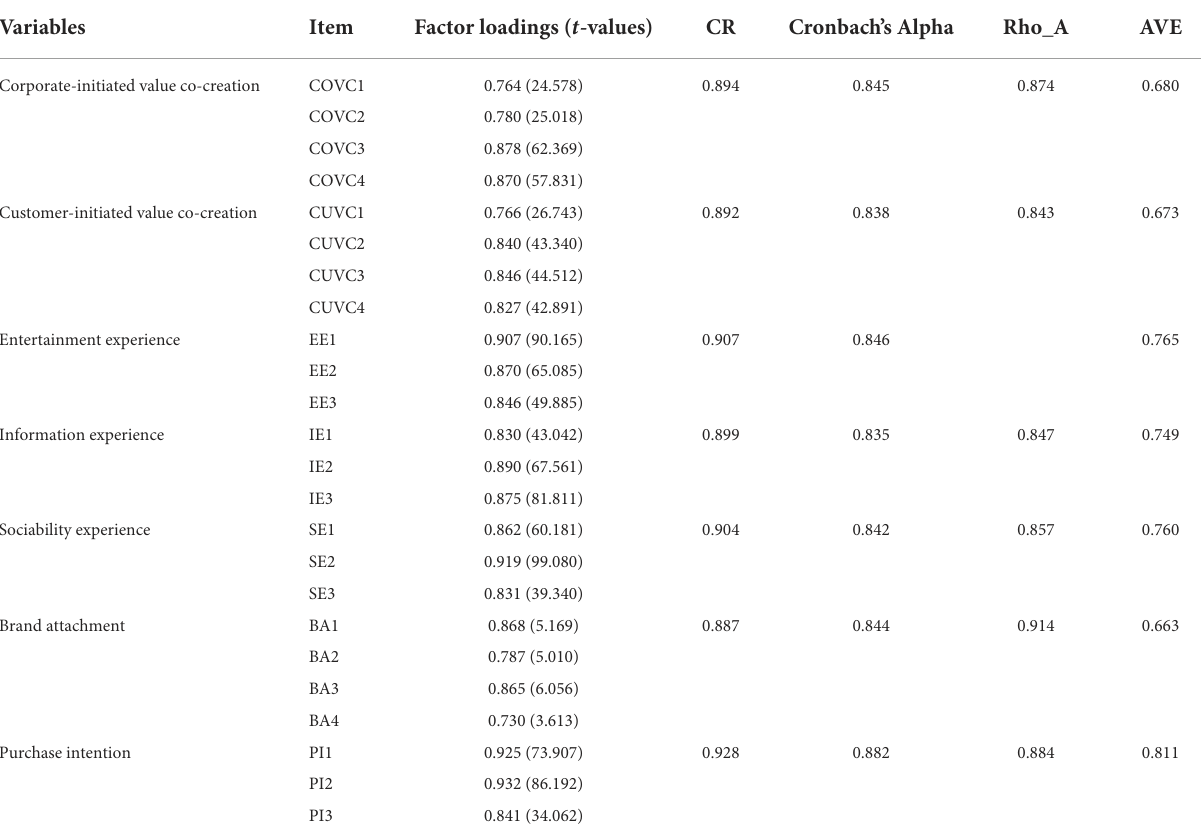
TABLE 2 Confirmatory factor analysis